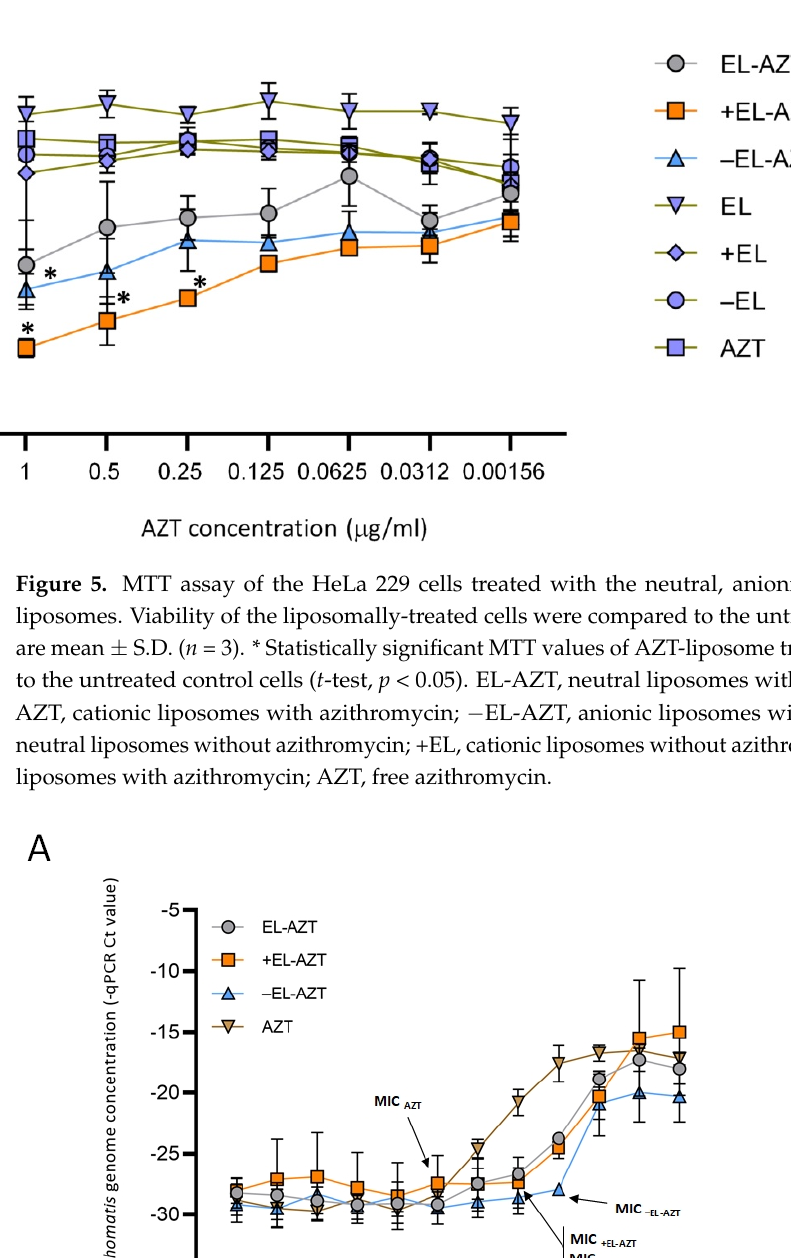
Figure 6. Impact of different types of AZT-liposomes on the growth of C. trachomatis serovar D. ( A ) Direct C. trachomatis growth in the presence of free AZT and liposomally-encapsulated AZT. ( B ) Recoverable C. trachomatis growth. Data are mean − qPCR Ct levels ± S.D. ( n = 3). EL-AZT, neutral liposomes with azithromycin; +EL-AZT, cationic liposomes with azithromycin; − EL-AZT, anionic liposomes with azithromycin.